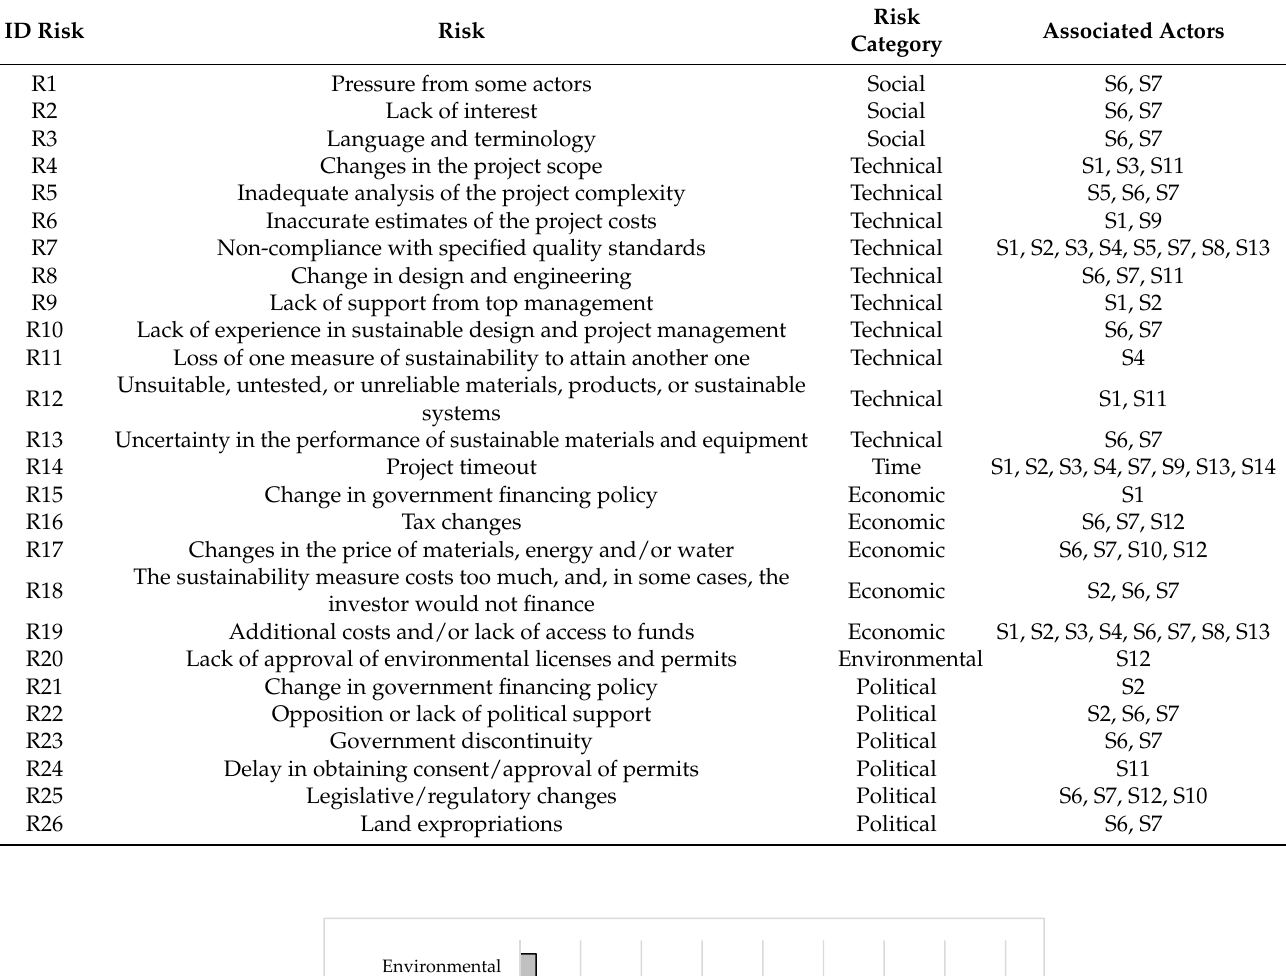
Table 3. Classification of actors by type of risk.